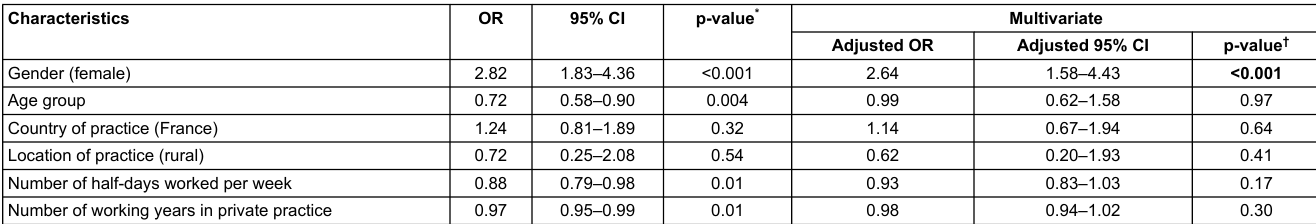
Table 4: Associations between frequent prescription of nonpharmacological home remedies (prescription for ≥ 10% of patients) and general practitioners’ sociodemographic characteristics.